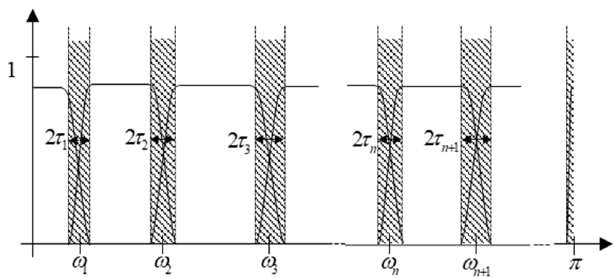
Figure 3. Segmentation of the Fourier spectrum.